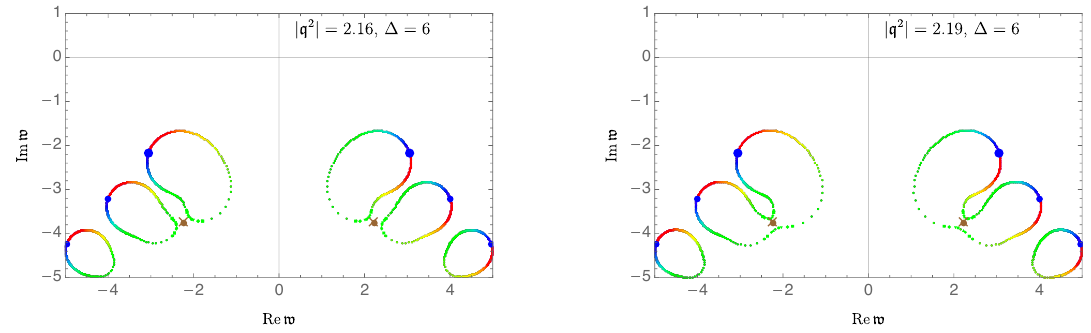
Figure 6 . Level-crossing. Poles of the retarded two-point function of the scalar operator, in the complex w − plane, at various values of the complexified momentum q 2 = | q 2 | e iθ . Blue dots correspond to the location of poles for real q 2 , namely for θ = 0 . As θ increases from 0 to 2 π , each pole moves counter-clockwise following the trajectory whose color changes continuously from blue to red. The two panels show the situation slightly before and after the collision point marked by brown dot-crosses. Before the collision the orbits of all QNMs are closed. At the critical value | q 2 the trajectories of the lowest-lying modes collide with those of the second QNMs. After the collision, orbits of mentioned modes are no longer closed: in both left and right sides of the plane, the lowest- lying and the second QNMs exchange their positions as the phase θ increases from 0 to 2 π .